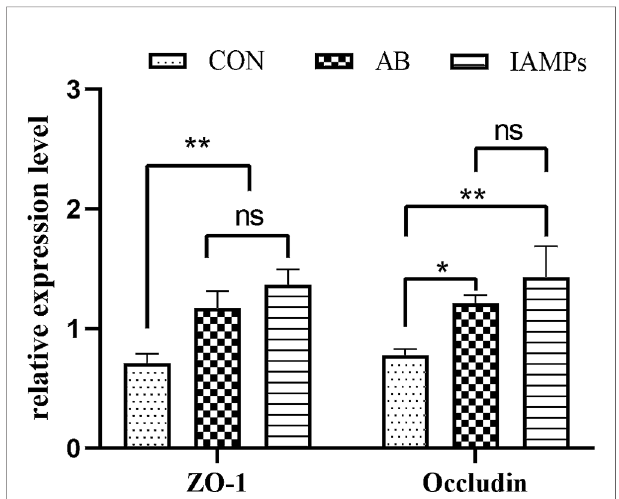
FIGURE 1 | Effects of IAMPs on tight junction structure of jejunum (n = 7). CON, corn – soybean-based diet; AB, CON + 25 mg/kg fl avomycin + 50